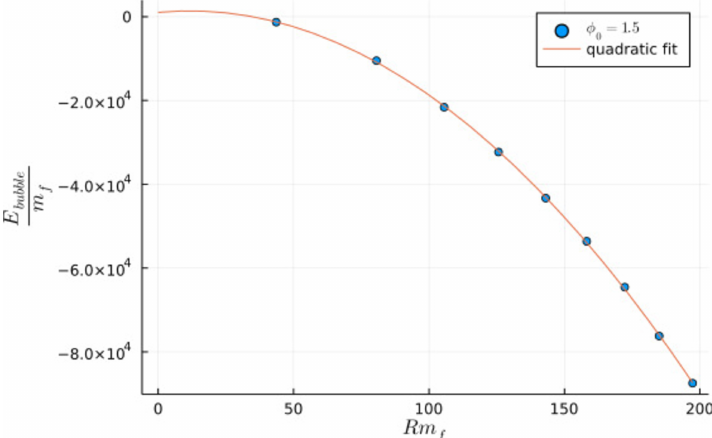
Figure 18 . The energy of the bubble as a function of its radius. The simulations parameters are = 512 2 , φ = 1 . 5 , am = 0 . 3 and (cid:15) = 0 . 8 N 2 0 f x